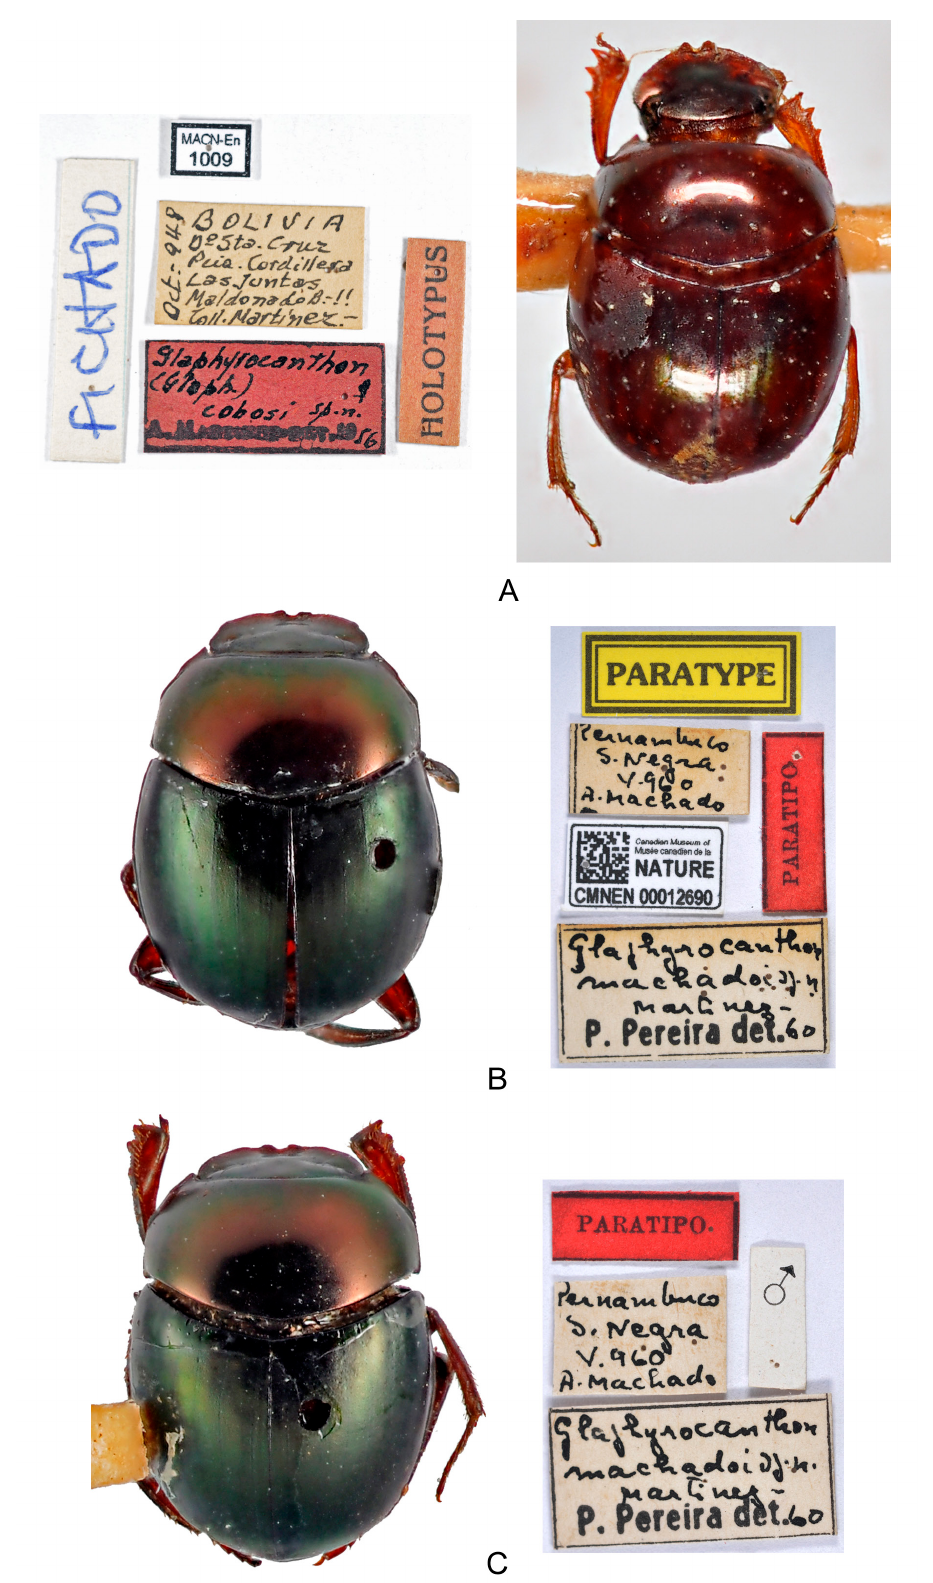
Fig. 46. A . Canthon cobosi (Pereira & Martínez, 1960) stat. et comb. nov., holotype. B–C . Canthon machadoi (Martínez & Pereira, 1967) comb. nov. B . Paratype 2. C . Paratype